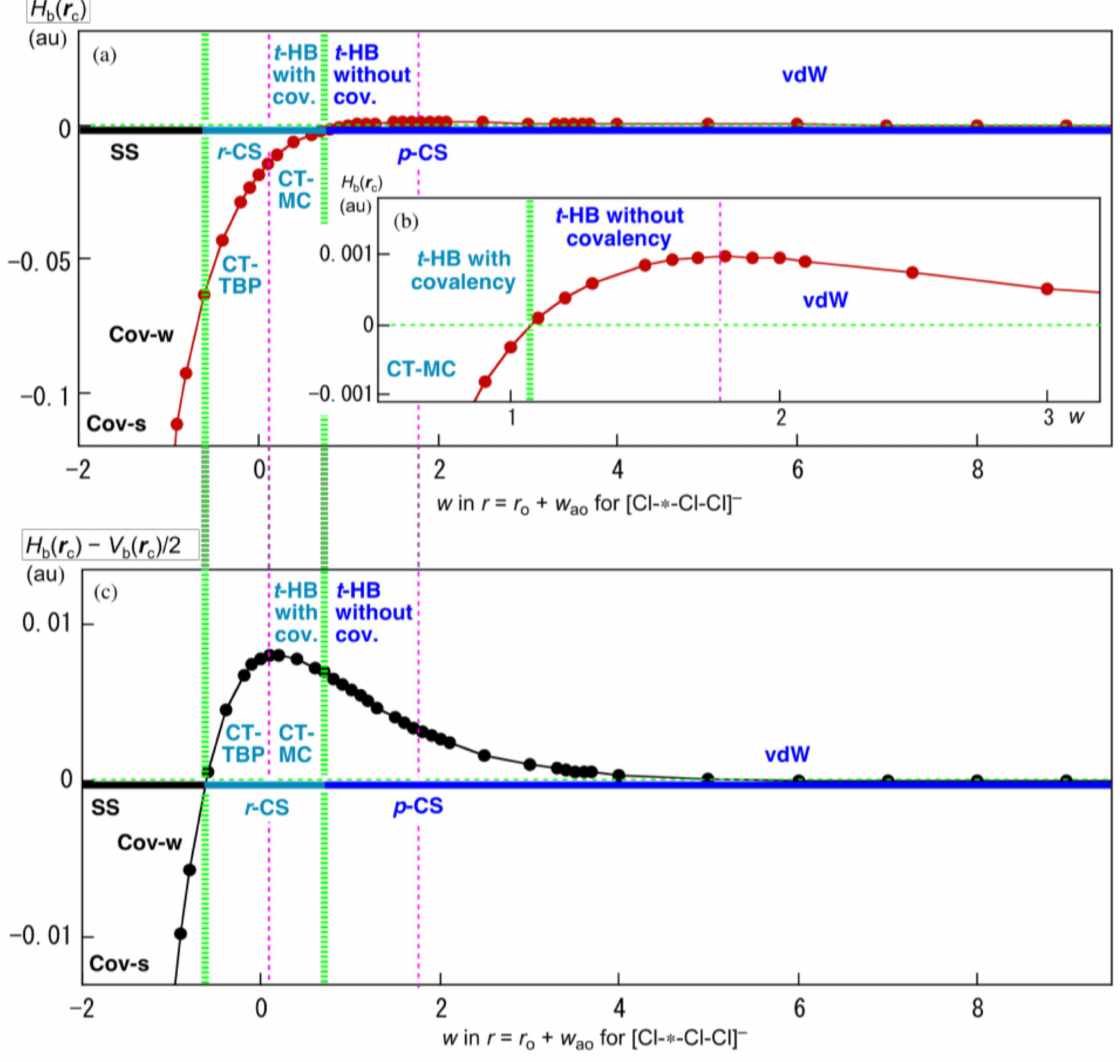
Figure A2. Plot of H b ( r c ) versus w in r ( 1 Cl- 2 Cl) = r o ( 1 Cl- 2 Cl) + wa o for [ 1 Cl- 2 Cl- 3 Cl] – (a) with the magnified picture of (a), (b) and that of H b ( r c ) – V b ( r c )/2 versus w (c). Typical hydrogen bonds without covalency and typical hydrogen bonds with covalency are abbreviated as t -HB without cov. and t -HB with cov., respectively, whereas Cov-w and Cov-s stand for weak covalent bonds and strong covalent bonds,